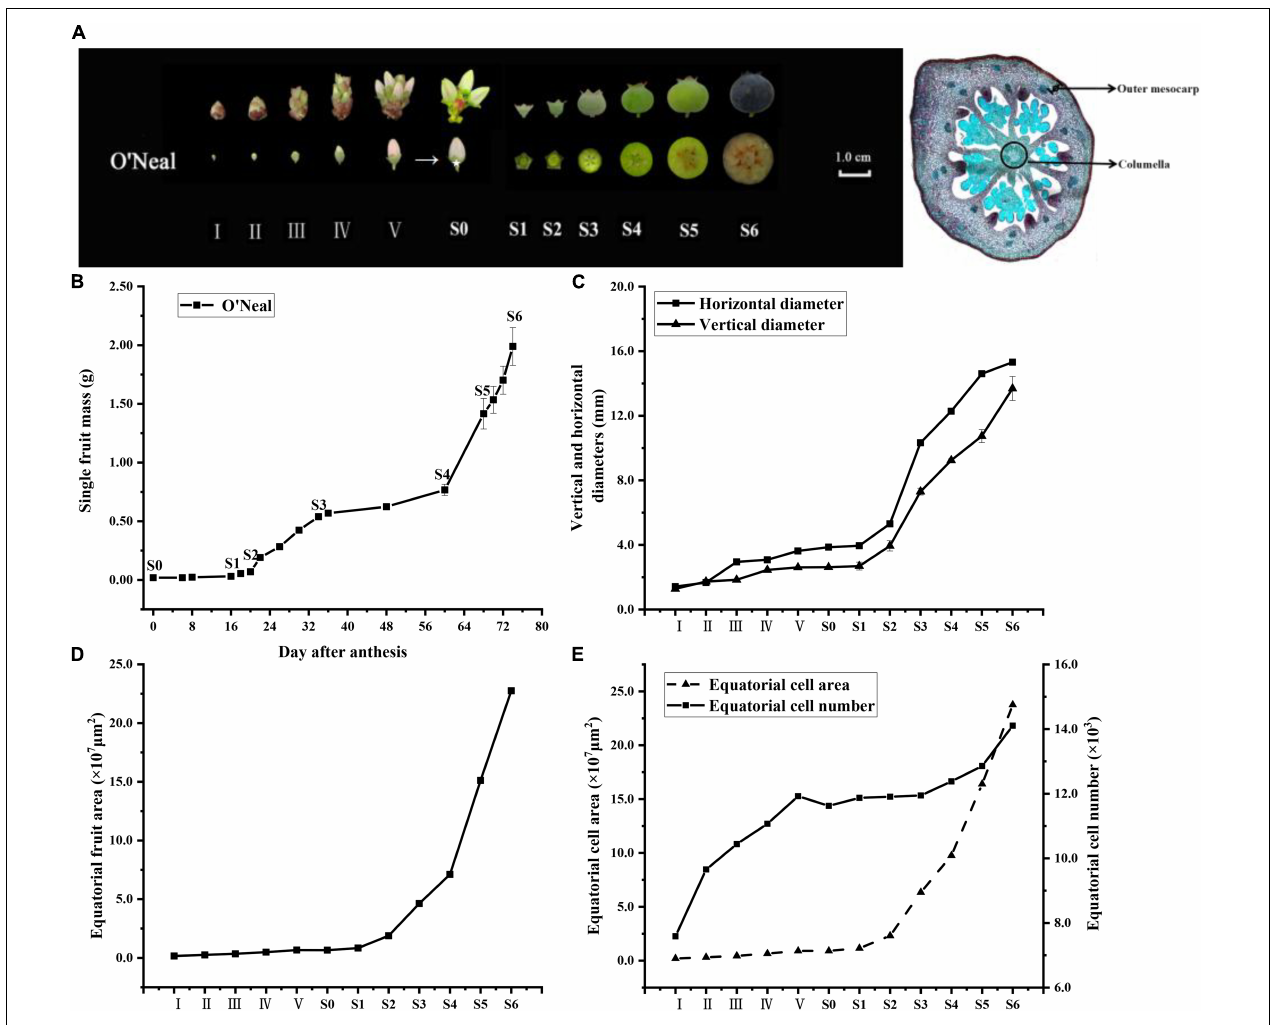
FIGURE 1 | Developmental stages of V. corymbosum ‘O’Neal’ flower bud and fruit. (A) The floral and berry development stages used in this study, and microscopic images of equatorial hypanthium at stage III (40 × magnification). (B) ‘O’Neal’ fruit growth curve. Error bars represented the SD of 60 flower buds and fruits. (C) Equatorial hypanthium/fruit dimensions (width and length) and (D) equatorial pericarp area at different developmental stages. Error bars represented the SD of three replicates (20 hypanthia and fruits at different developmental stages were used for each replicate). (E) Cell numbers and cell area of equatorial hypanthium/fruit sections in different developmental stages. Error bars represented the SD of 3 ∼ 5 hypanthia and fruits.Hypanthium (the white asterisk location in the A ) is the receptacle and inferior tissues of flower bud without stamens, pistil and petals and form fruit after pollination and fertilization. Outer mesocarp is the region between the hypodermis and the first large vascular bundle, and columella is the central axis of fruit.